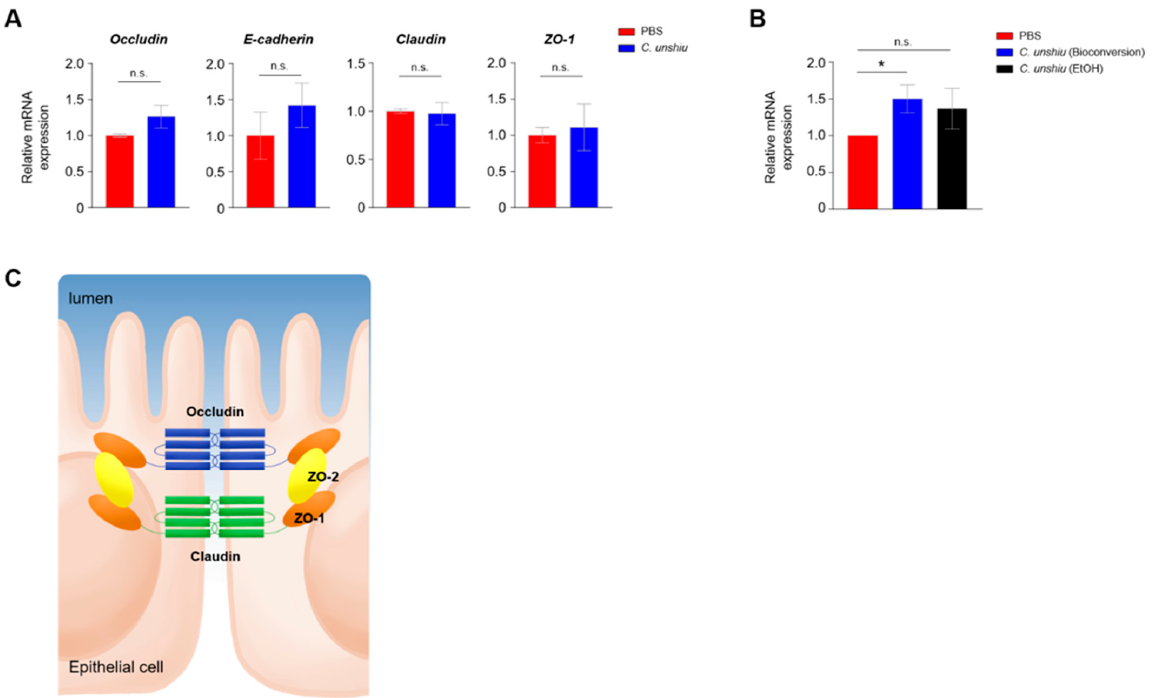
Figure 5. CUP enhances the intestinal integrity. ( A ) Quantitative reverse-transcriptase polymerase chain reaction (qRT-PCR) analysis of the expression levels of tight junction-related genes in Caco-2 cells after treatment with the ethanol extracts of CUP. ZO, zonula occludens. ( B ) The mRNA expres- sion levels of occludin were determined in Caco-2 cells after CUP treatment (bioconversion of CUP). The locations of diverse genes associated with intercellular tight junction are illustrated in panel ( C ). The statistical analyses were conducted using an unpaired one-tailed t -test. * p < 0.05; n.s., not sig- nificant.